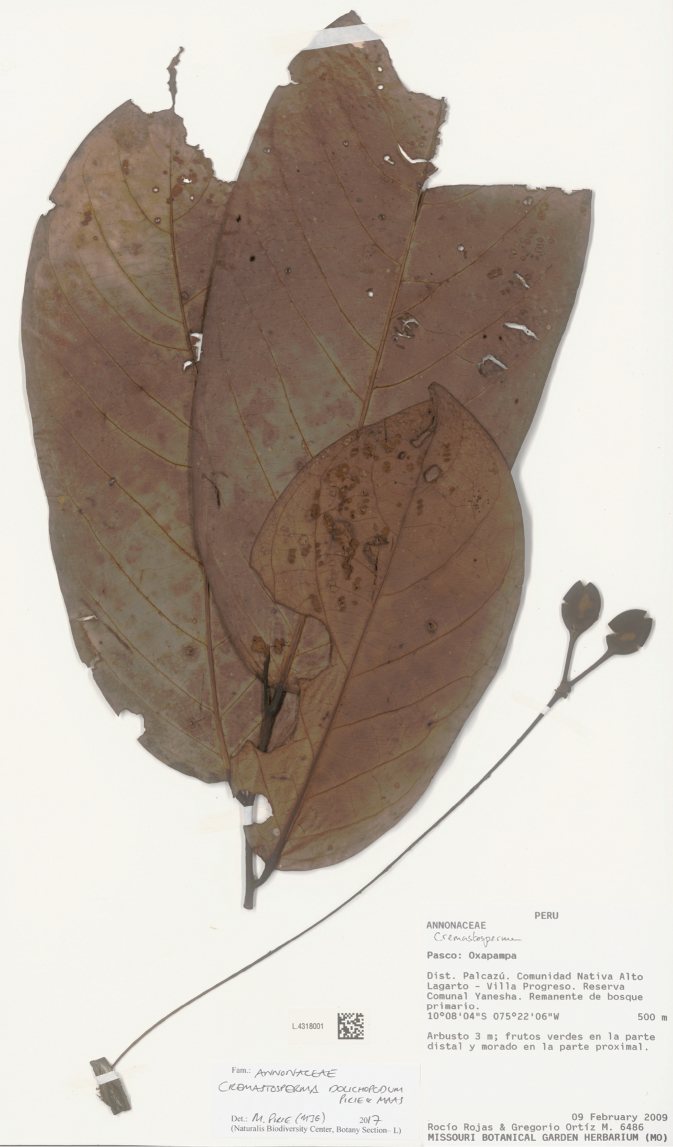
Cremastospermadolichopodum Pirie & Maas. Fruiting specimen (Rojas & Ortíz 6486).